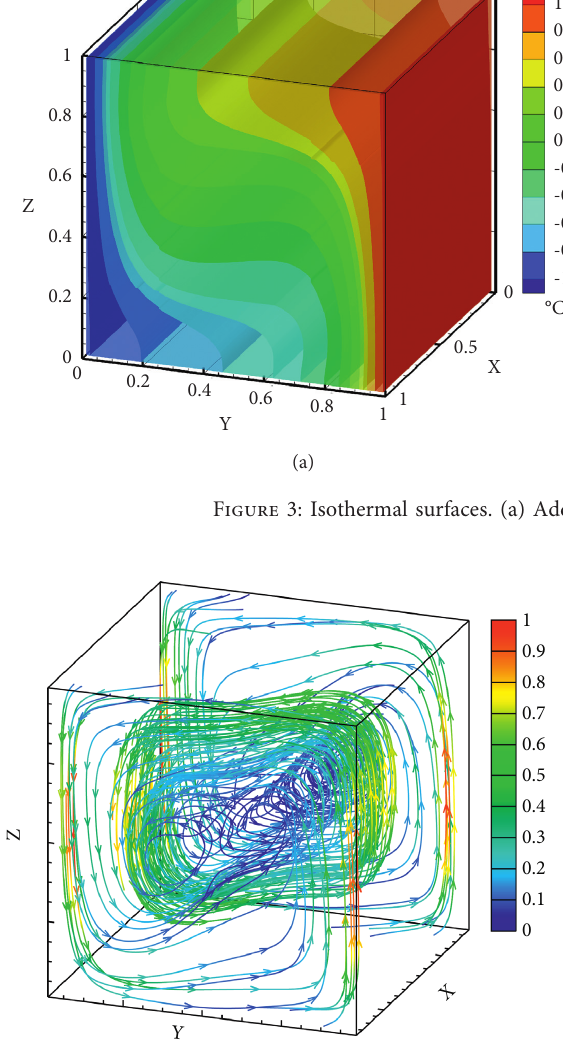
Figure 4: Streamline and velocity gradients of added driving flows. Figure 5: Local Nu/Sh number of the added driving flows along the right